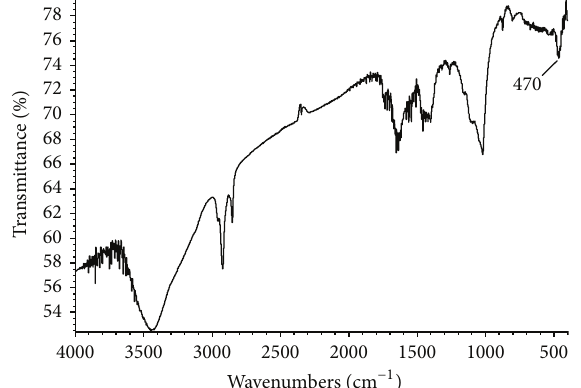
Figure 4: IR Spectra of HMNPs: oxidized MWCNTs decorated with Fe 3 O 4